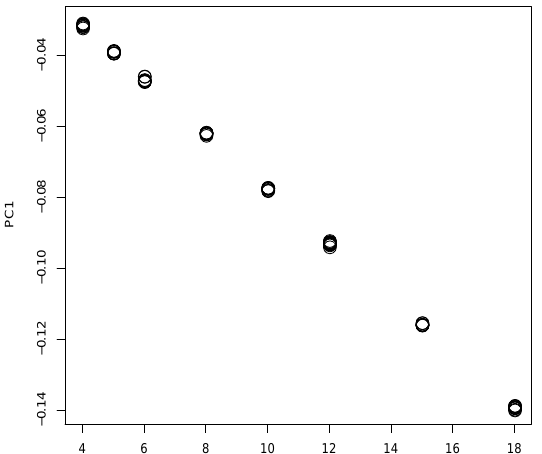
Figure 11. The 1st PC loading computed by PCA applied to synthetic data. Horizontal axis: (cid:108) j (cid:109) (cid:16)(cid:108) (cid:109) (cid:17) k + 3 ,1 ≤ j , k ≤ 3. Averaged over 100 independent 3 3